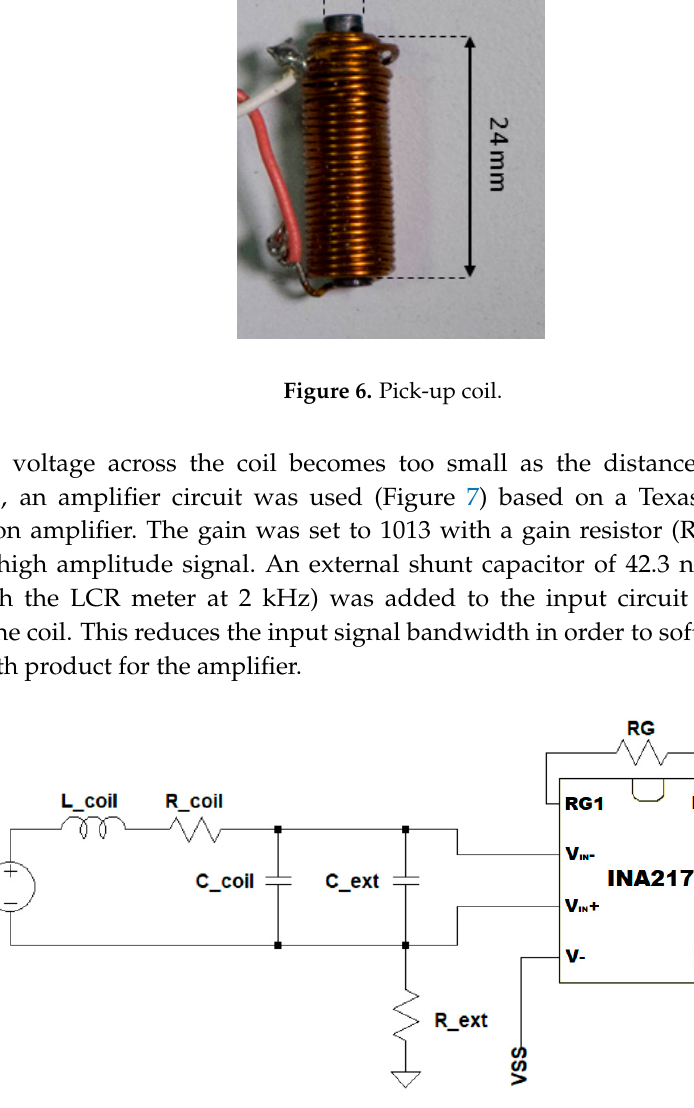
Figure 7. Amplifier circuit based on the INA217 instrumentation amplifier. The input loop is the RLC series circuit model of the coil, with a shunt capacitor to adjust the resonance frequency and a resistor to ground to bias the input of the amplifier. R G is the gain regulation resistor.